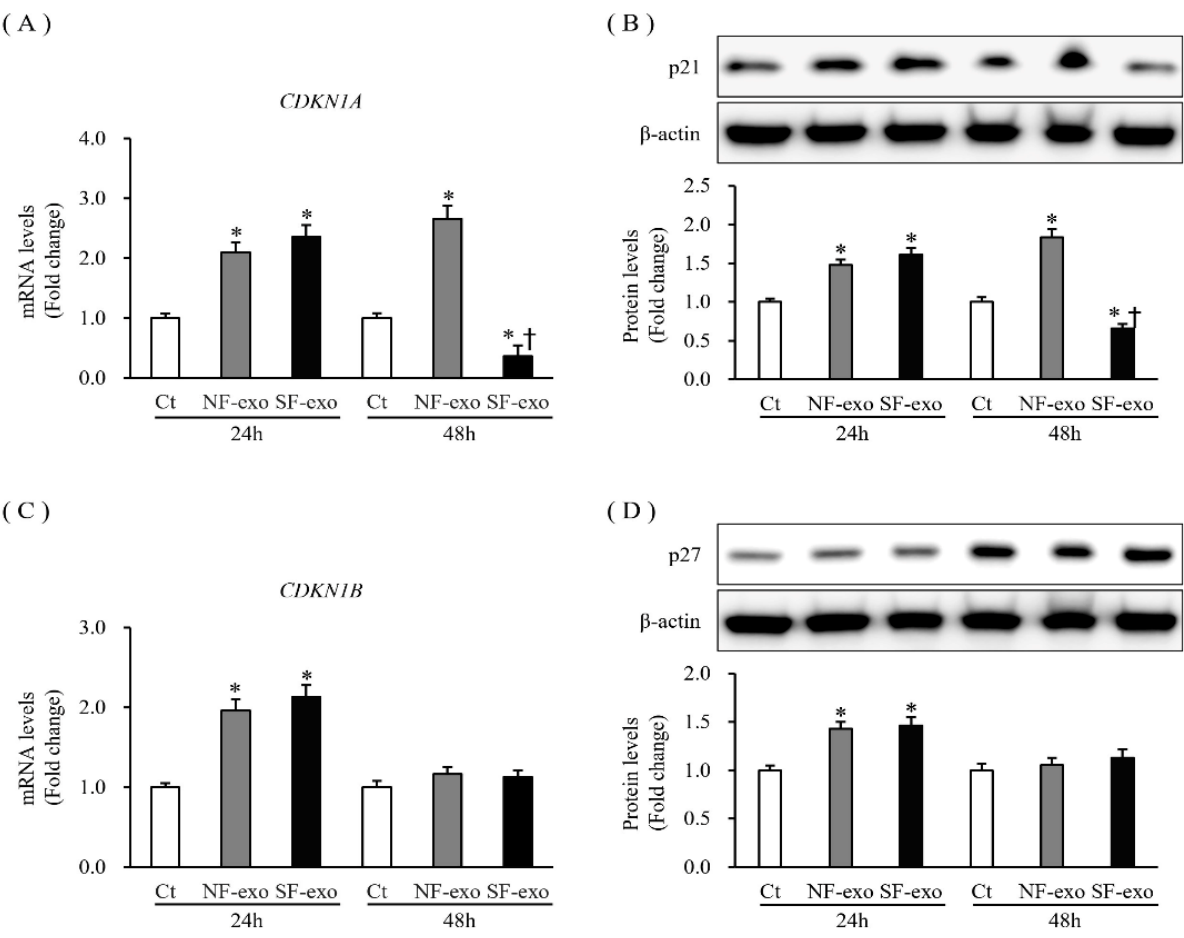
Figure 6. Expression of cyclin-dependent kinase inhibitors in NHKs after NF- or HTSF-exosome treatment. The mRNA and protein expression of p21 ( CDKN1A ) ( A , B ) in NHKs increased significantly at 24 and 48 h after treatment with 100 µ g/mL NF- or HTSF-exosome treatment but decreased with HTSF-exosome treatment at 48 h compared with that in the control cells. The mRNA and protein expression of p27 ( CDKN1B ) ( C , D ) in NHKs increased significantly at 24 h and was unchanged at 48 h after treatment with 100 µ g/mL NF- or HTSF-exosomes, respectively, compared with that in the control cells. * p < 0.05 for NF- or HTSF-exosome-treated cells versus the corresponding matched control cells. † p < 0.05 for HTSF-exosome-treated cells versus NF-exosome-treated cells. Data represented with mean ± SD; n = 4. Ct, DPBS-treated control cells; NHK, normal human keratinocytes; NF, normal tissue-derived fibroblasts; HTSF, hypertrophic scar tissue-derived fibroblasts.